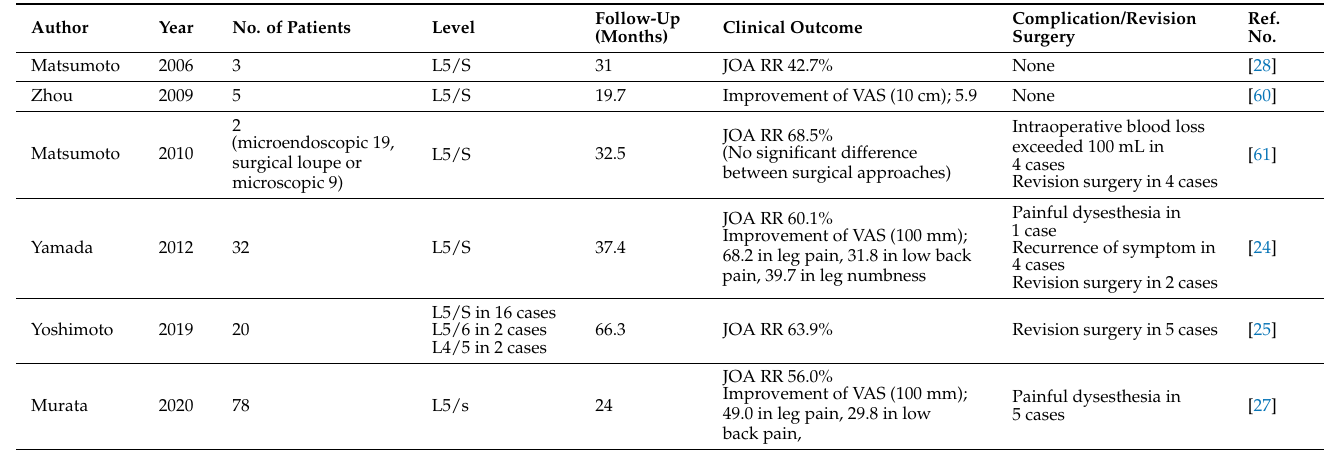
Table 2. Clinical results of microendoscopic decompression for lumbar foraminal